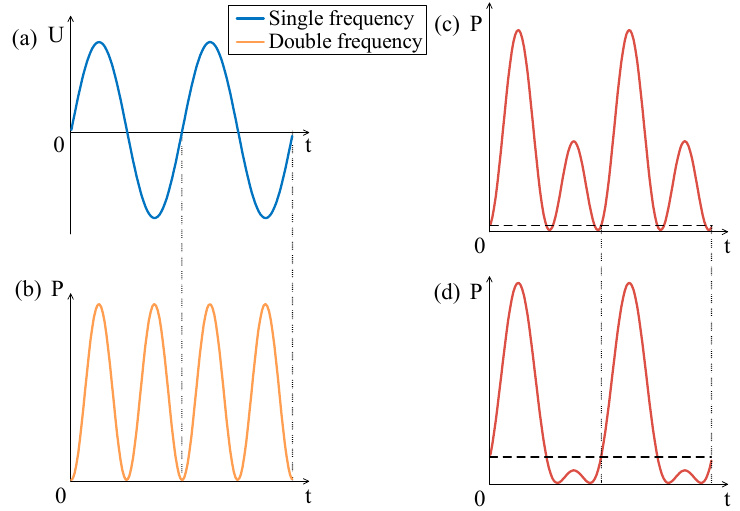
Figure 3. ( a ) AC excitation with amplitude of 5 V. Electric power with ( b ) AC = 5 V; ( c ) AC = 5 V and DC = 1 V; ( d ) AC = 5 V and DC = 3 V.